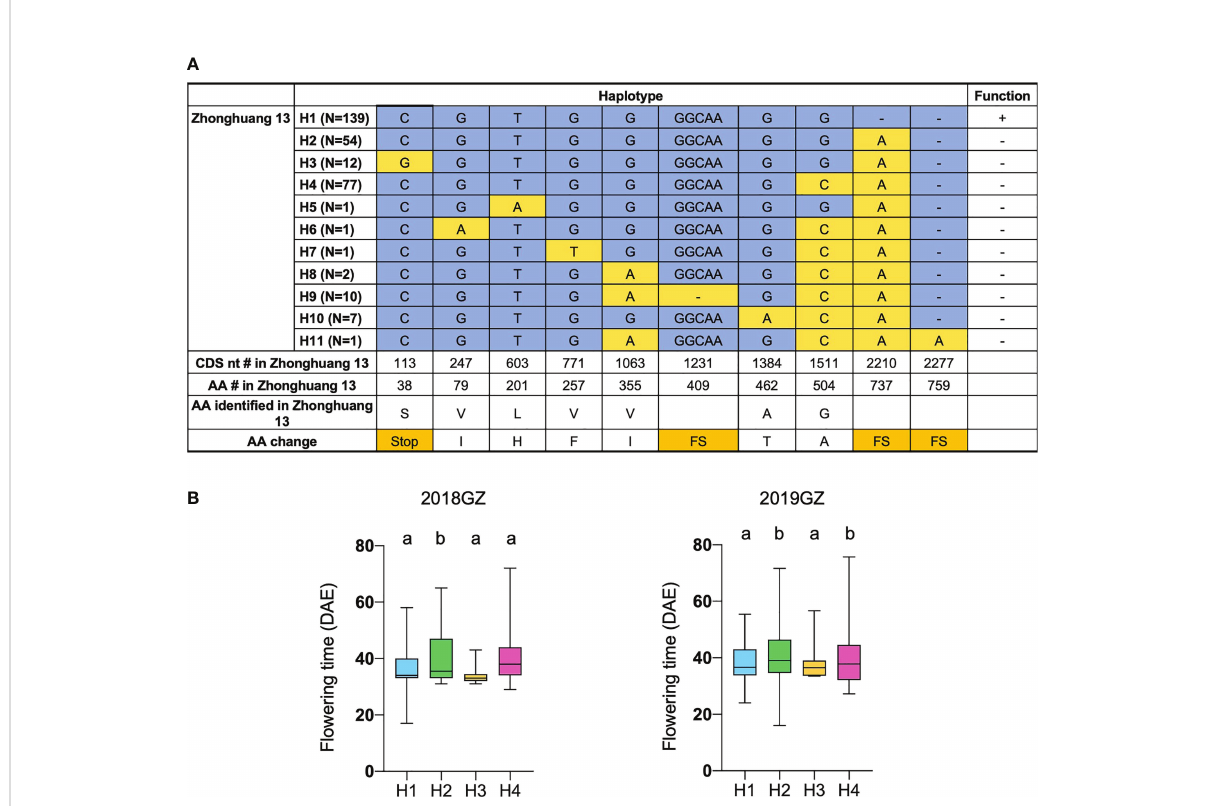
FIGURE 4 Flowering time of different alleles of Tof11. (A) Haplotypes and their origins of Tof11. FS, frameshift. (B) Flowering time of eleven haplotypes of Tof11 from the 338-accession panel. 20GZ, the accessions were planted in Guangzhou, China, in 2020; 18GZ, planted in Guangzhou, China, 2018. Two-tailed, two-sample t-test were used to generate the P values. Data represent mean ± SD of three biological replicates. Different lowercase letters represent signi fi cant differences at the level of P < 0.05, based on the Student ’ s t